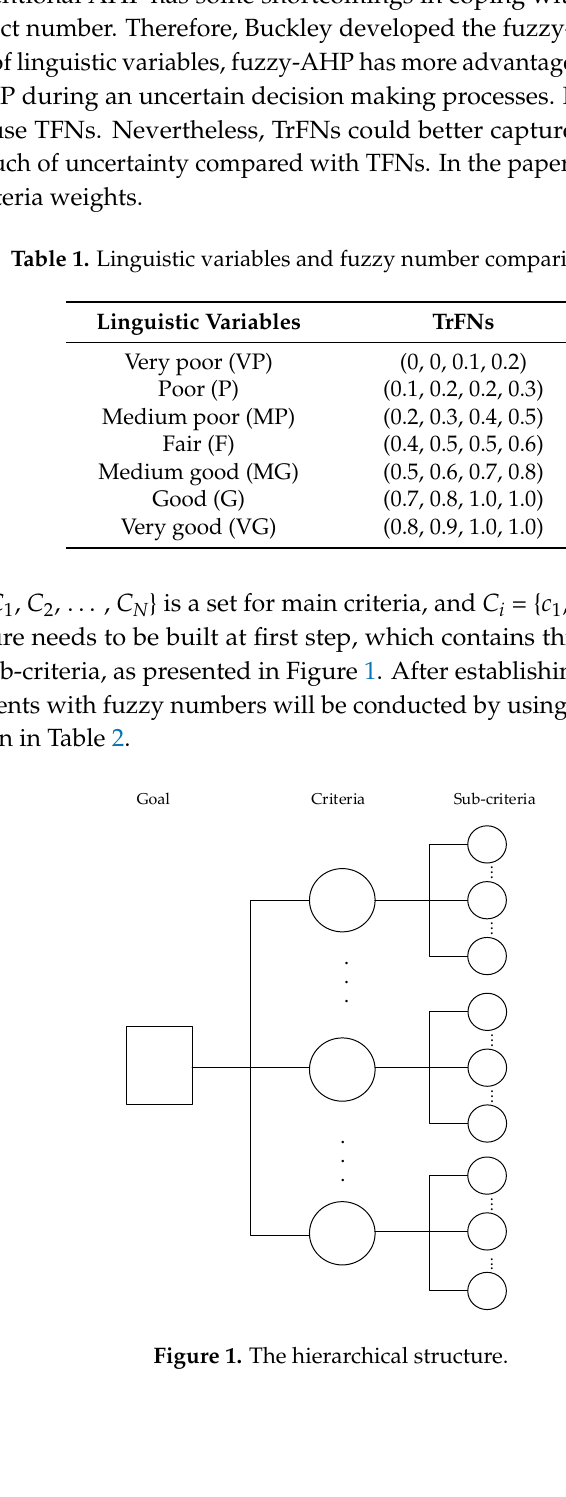
Table 1. Linguistic variables and fuzzy number comparison [50].